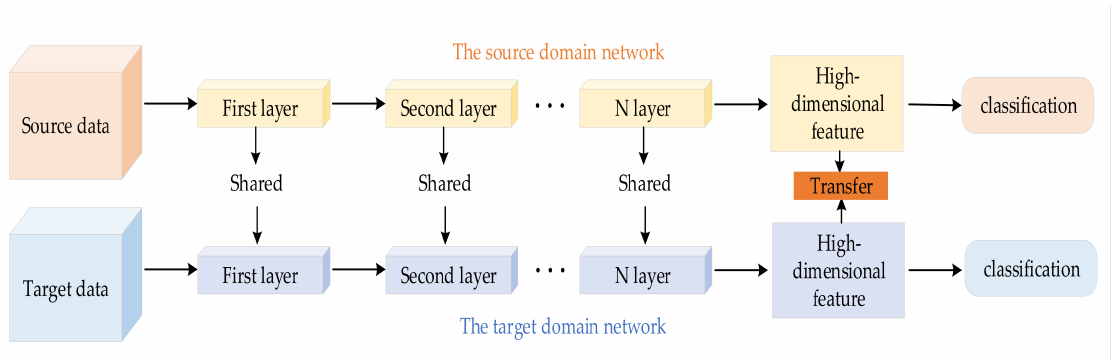
Figure 1. The general frame diagram of domain